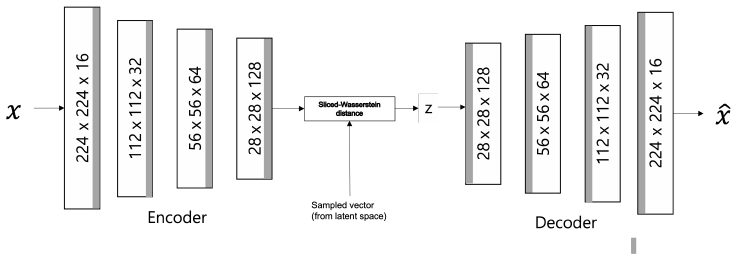
Figure 8. SWAE model